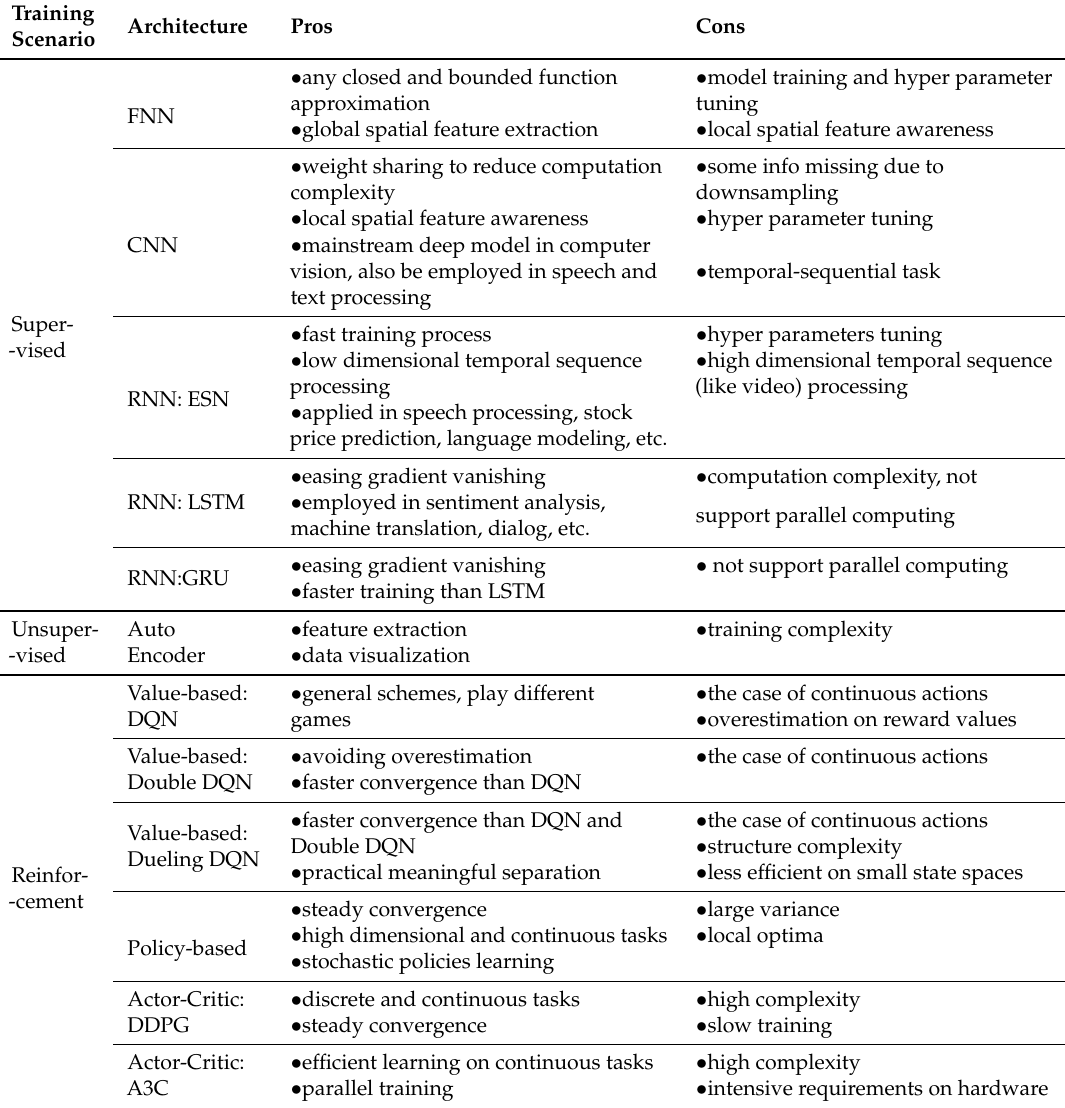
Table 2. Comparison of deep learning (DL)